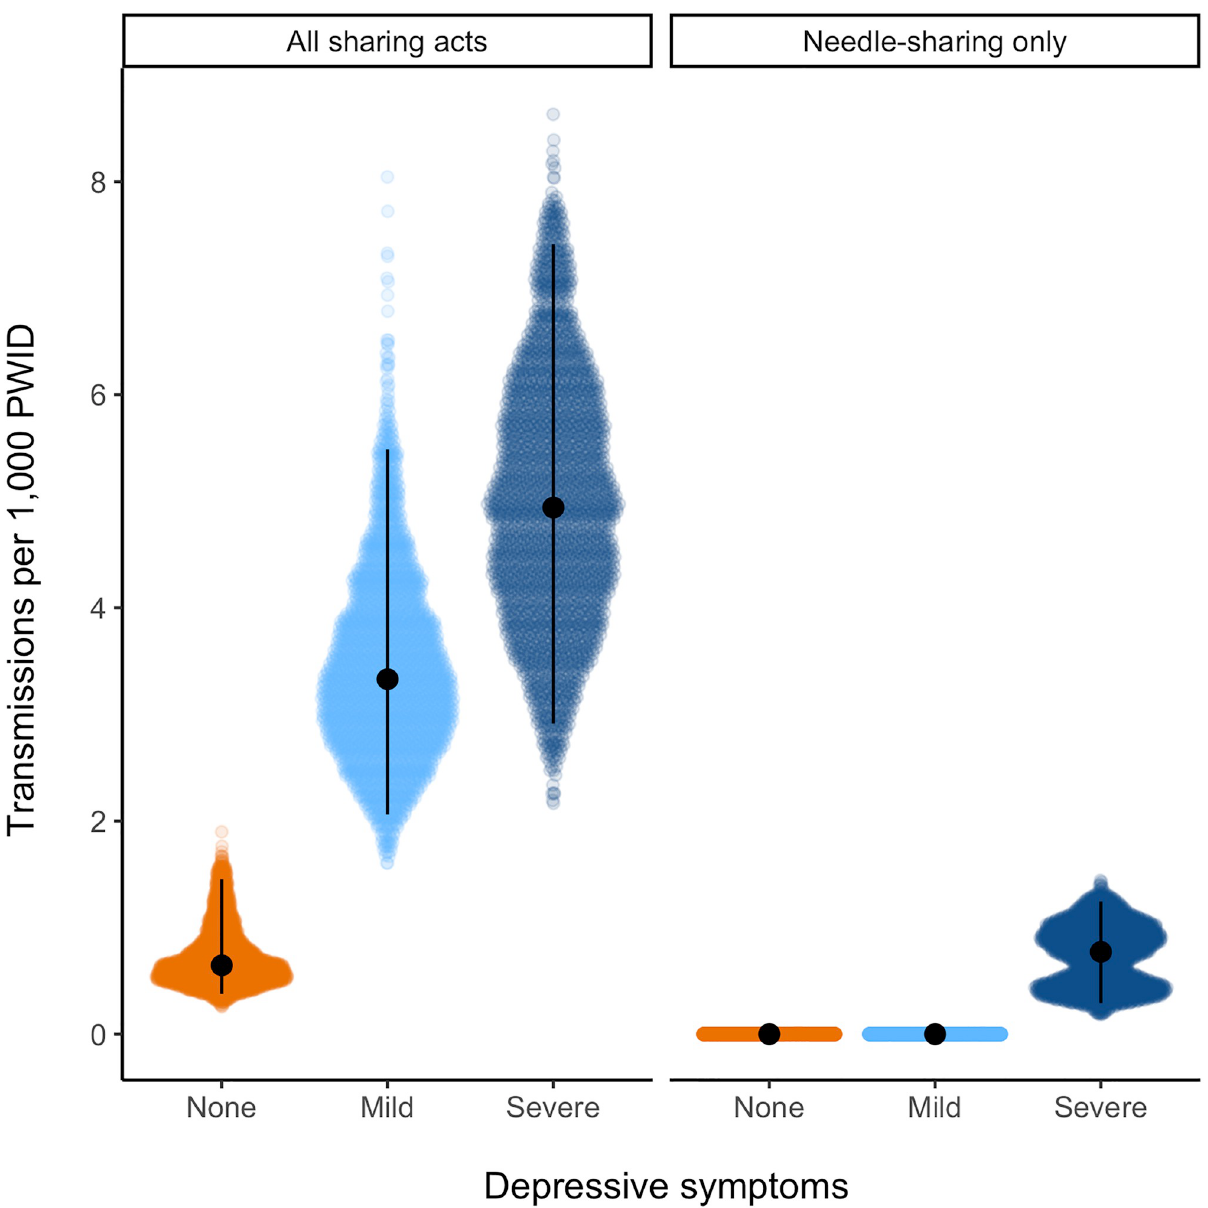
Fig 3. Modeled secondary transmission events in follow-up months 3–6 per 1,000 PWID living with HIV in each depressive symptom category. Estimates from 2,500 model runs are plotted by type of sharing act (all sharing acts vs. only needle-/syringe-sharing). Colored regions show all 2,500 estimates, the black point is the median, and the vertical line extends from the 2.5 th to 97.5 th